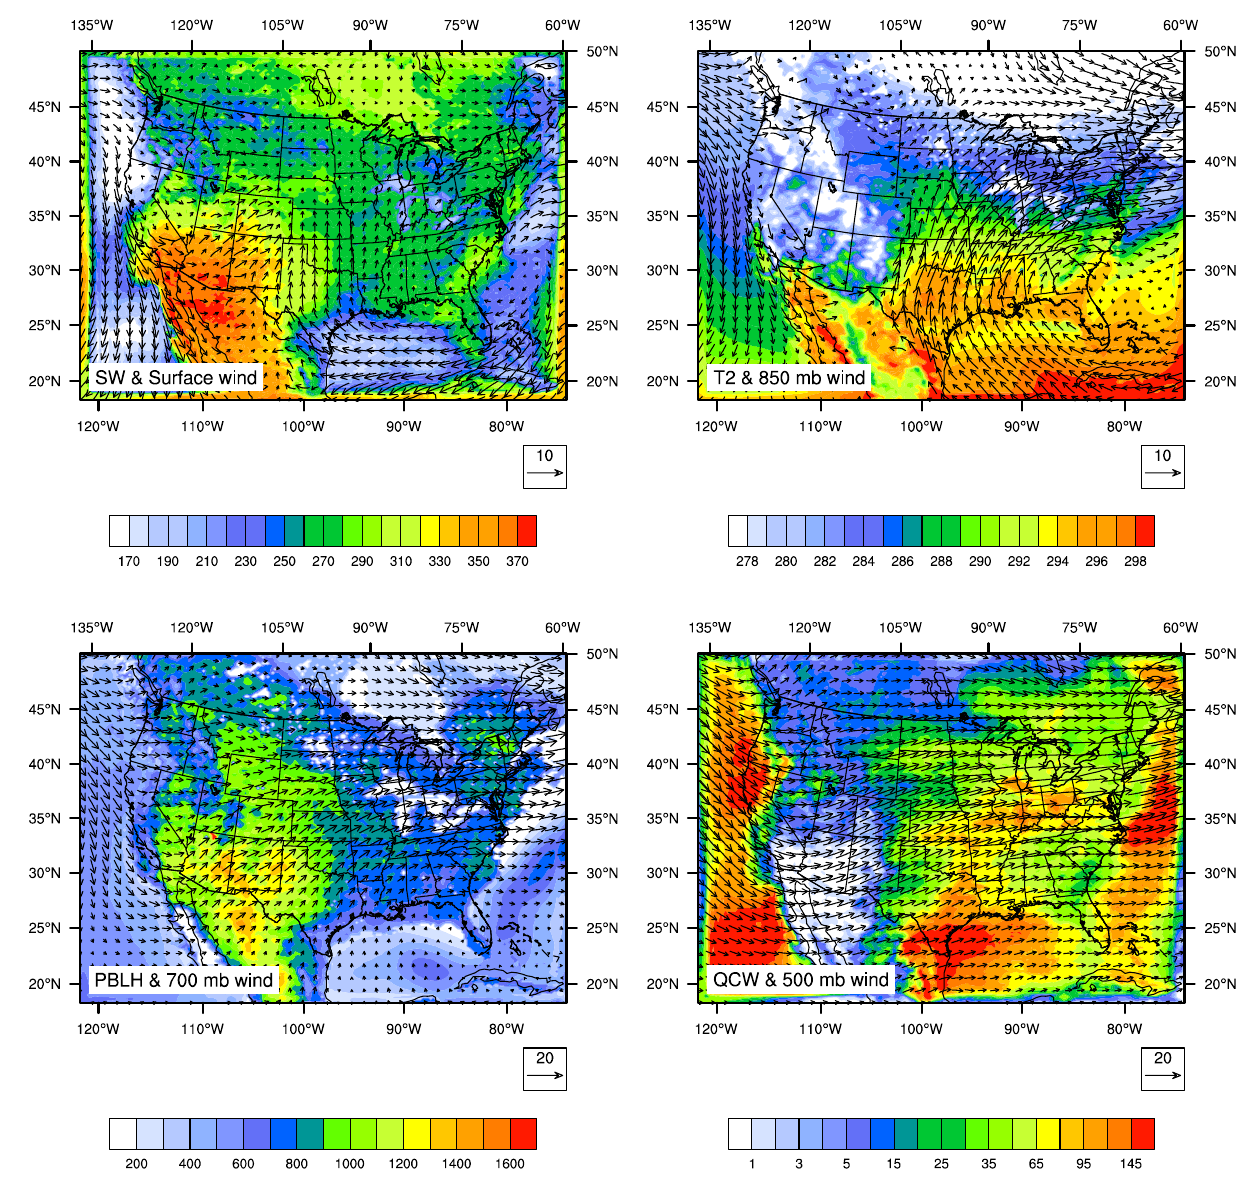
Figure 1. Spatial distributions of the three-month average downward shortwave radiation (SW, W·m − 2 ), T2 (K), planetary boundary layer height (PBLH, m), and cloud liquid water path (QCW, g·m − 2 ) from the experiment NoACR. The wind (m·s − 1 ) overlaying the above meteorological parameters is at surface 850 mb, 700 mb, and 500 mb,